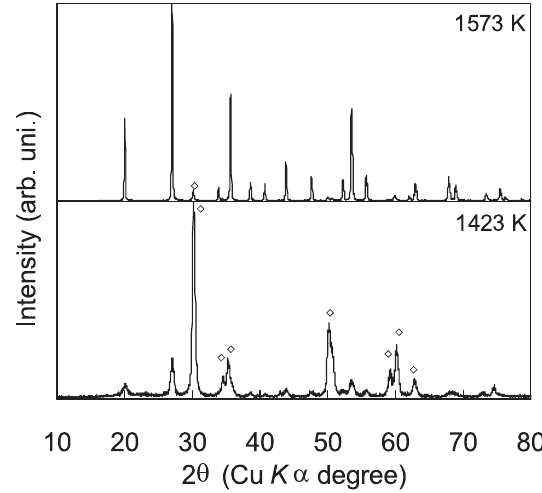
Table 2. Structural parameters of near neighbour correlations for ZrSiO 4 dried gels.